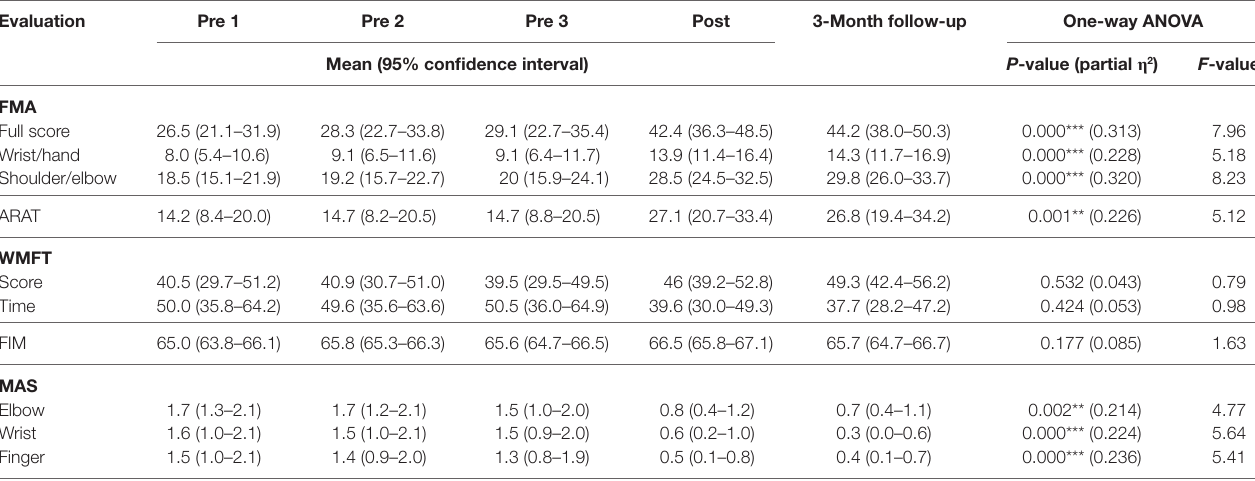
TaBlE 2 | The means and 95% confidence intervals for each measurement of the clinical assessments, and the probabilities with the estimated effect sizes of the statistical analyses.